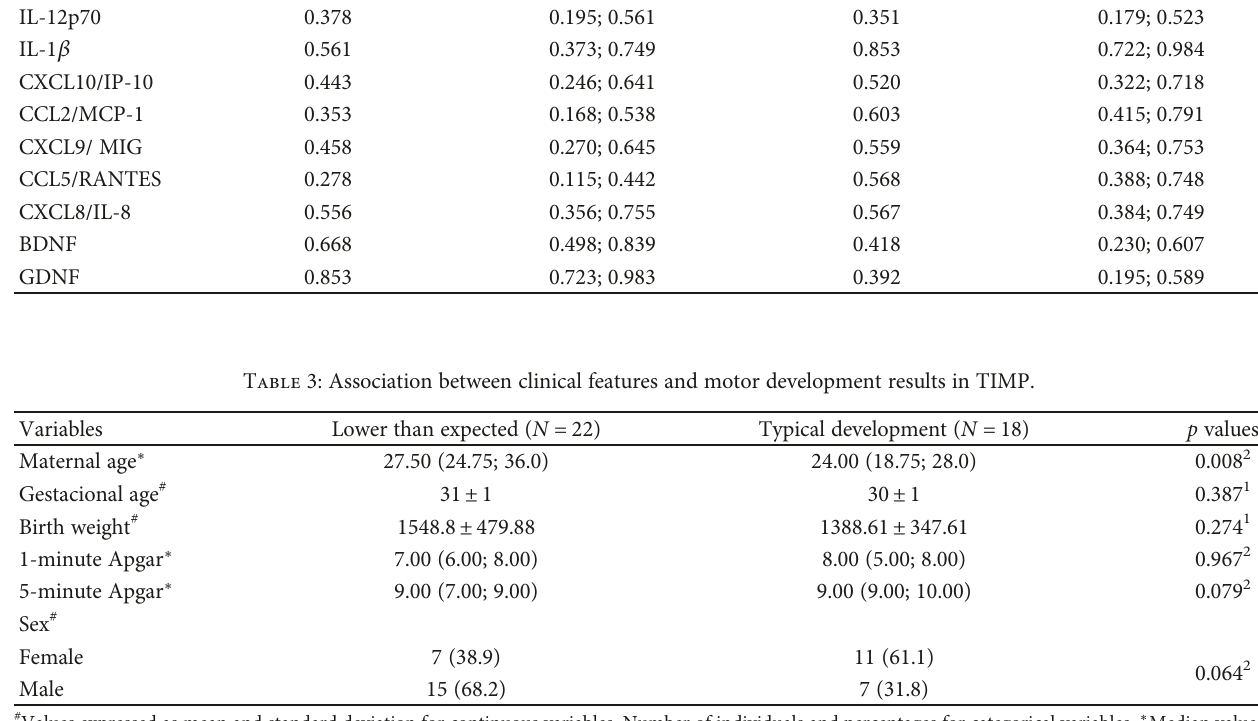
# Values expressed as mean and standard deviation for continuous variables. Number of individuals and percentages for categorical variables. ∗ Median values (quartile 1; quartile 3). 1 Student ’ s t -test. 2 Mann – Whitney test.